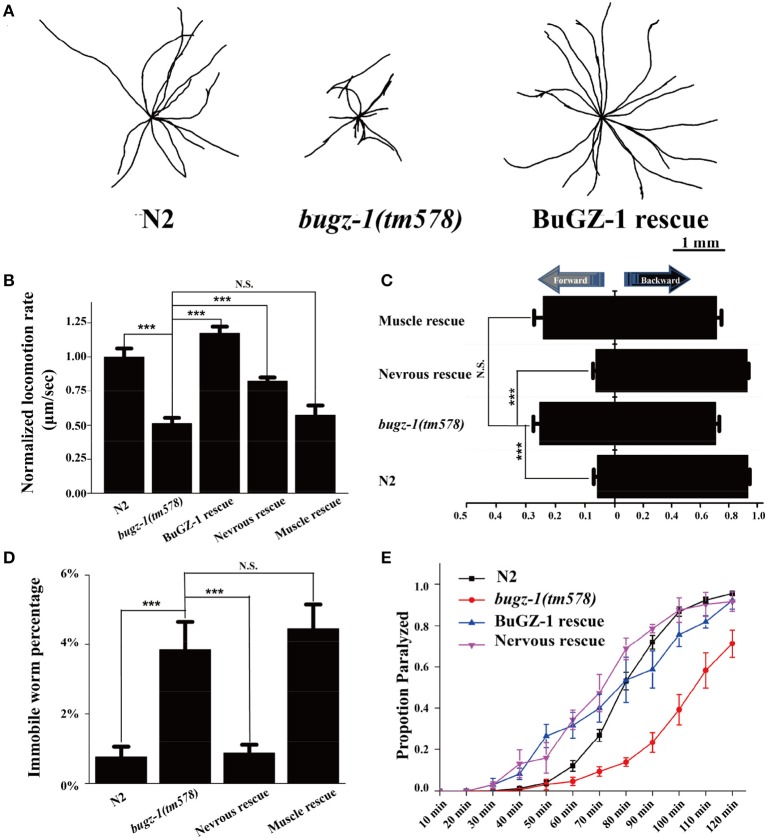
BuGZ-1 regulates acetylcholine secretion and worm locomotion. (A,B)
bugz-1(tm578) animals displayed more hesitating and uncoordinating movement with decreased trajectories (A) and locomotion speed (B). The locomotion rate is the average velocity of each worm in 40 seconds. (C,D)
bugz-1(tm578) mutant worms prefer to move backward or stay immobile. (C) Statistic comparison of average proportion of time spent on moving forward or backward for indicated worms. (D) Percentage of worms stay immobile in indicated genotypes. All the locomotion defects of bugz-1(tm578) can be rescued by endogenous expressed BuGZ-1 (bugz-1::gfp) and nervous expressed BuGZ-1 (rab-3p::bugz-1::mCherry) but not muscle expressed BuGZ-1 (myo-3p::bugz-1::mCherry) in mutation background. The number of worms analyzed for locomotion is n = 15 for each genotype. (E) Proportion paralyzed over time from indicated worm strains exposed to 1 mM aldicarb. Aldicard resistance defect of bugz-1(tm578) was rescued by endogenous expressed BuGZ-1 and nervous expressed BuGZ-1 but not muscle expressed BuGZ-1 in mutation background. 25–35 young adult animals were tested for aldicarb resistant experiment, at least three independent experiments were performed. Values that significantly differ from controls are indicated (***p < 0.001 by two-tails Student's t-test). N.S. indicates no significant difference from worm genotypes compared. Error bars represent SEM.